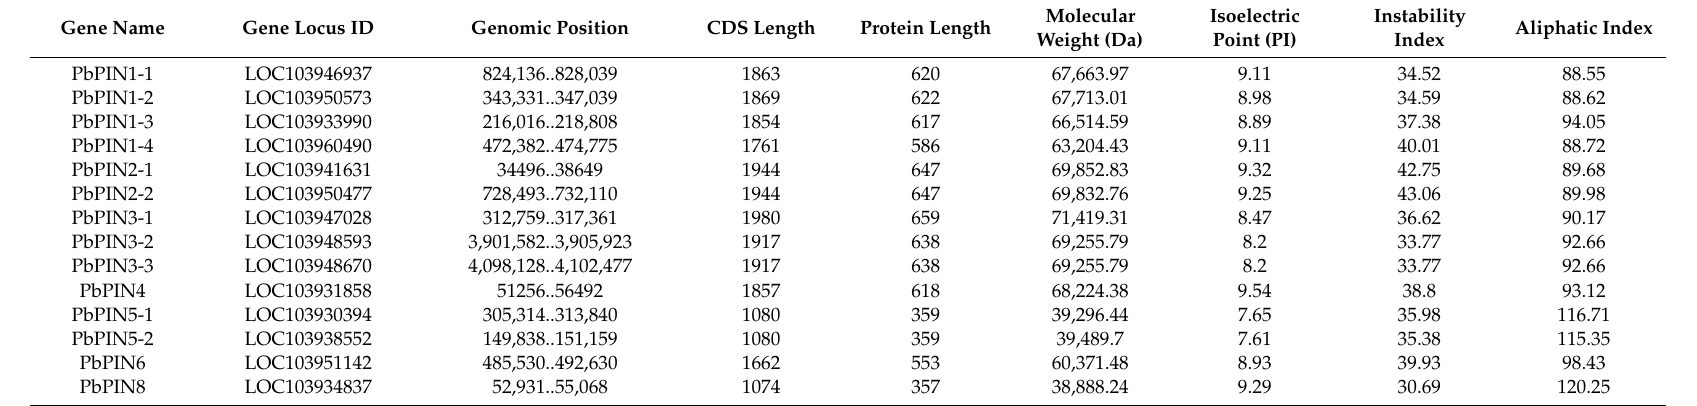
Table 2. Characteristics of PIN members in